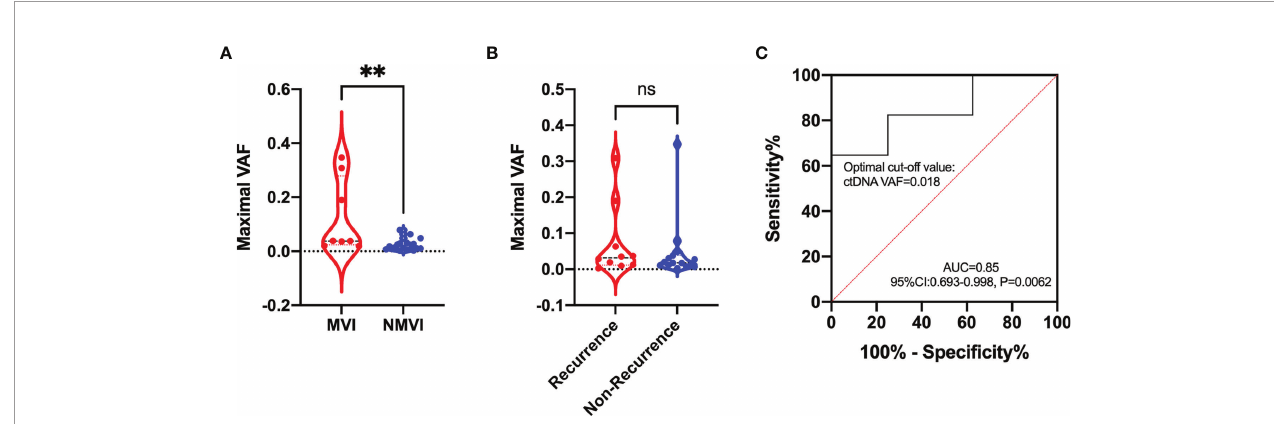
FIGURE 6 | Comparison of the maximal VAF of ctDNA between (A) MVI and NMVI groups; (B) recurrence and non-recurrence groups. (C) ROC curve indicating the performance of ctDNA maximal VAF in determining the presence of MVI in plasma samples. ** indicates p-value < 0.01; ns indicates p-value >